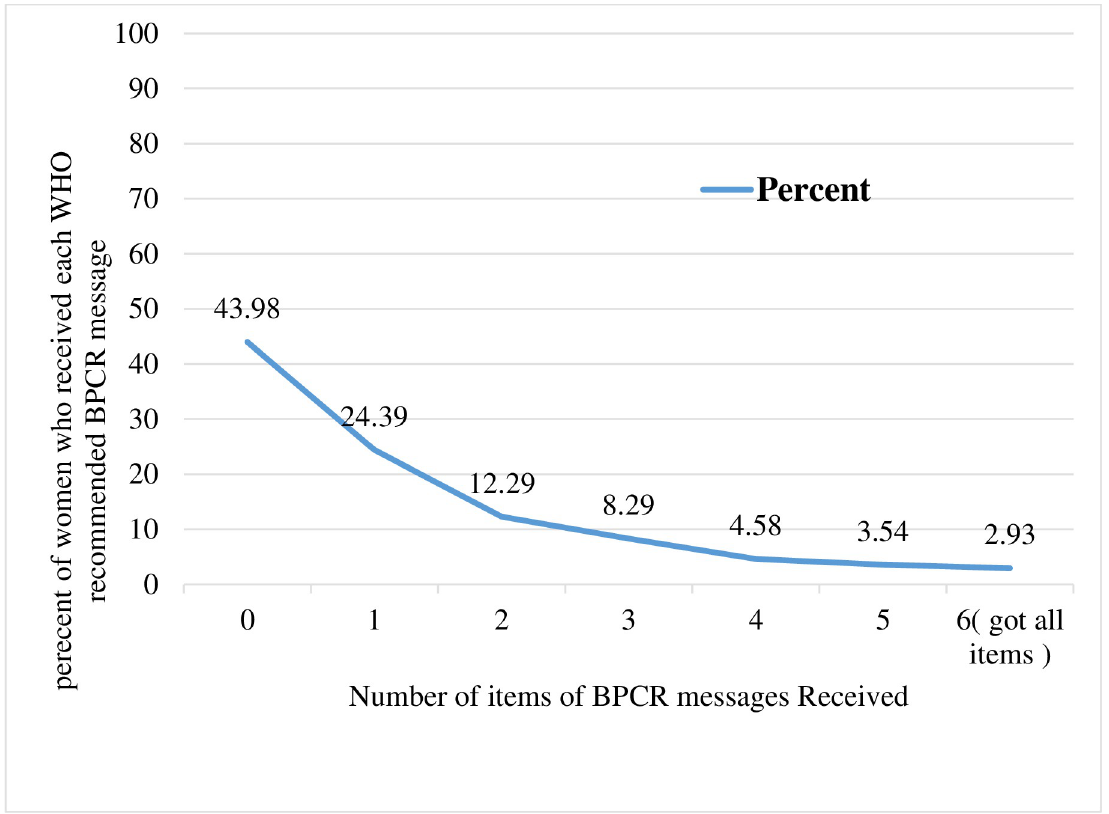
Fig 1. Number of BPCR messages received by women during their recent pregnancy in Ethiopia,